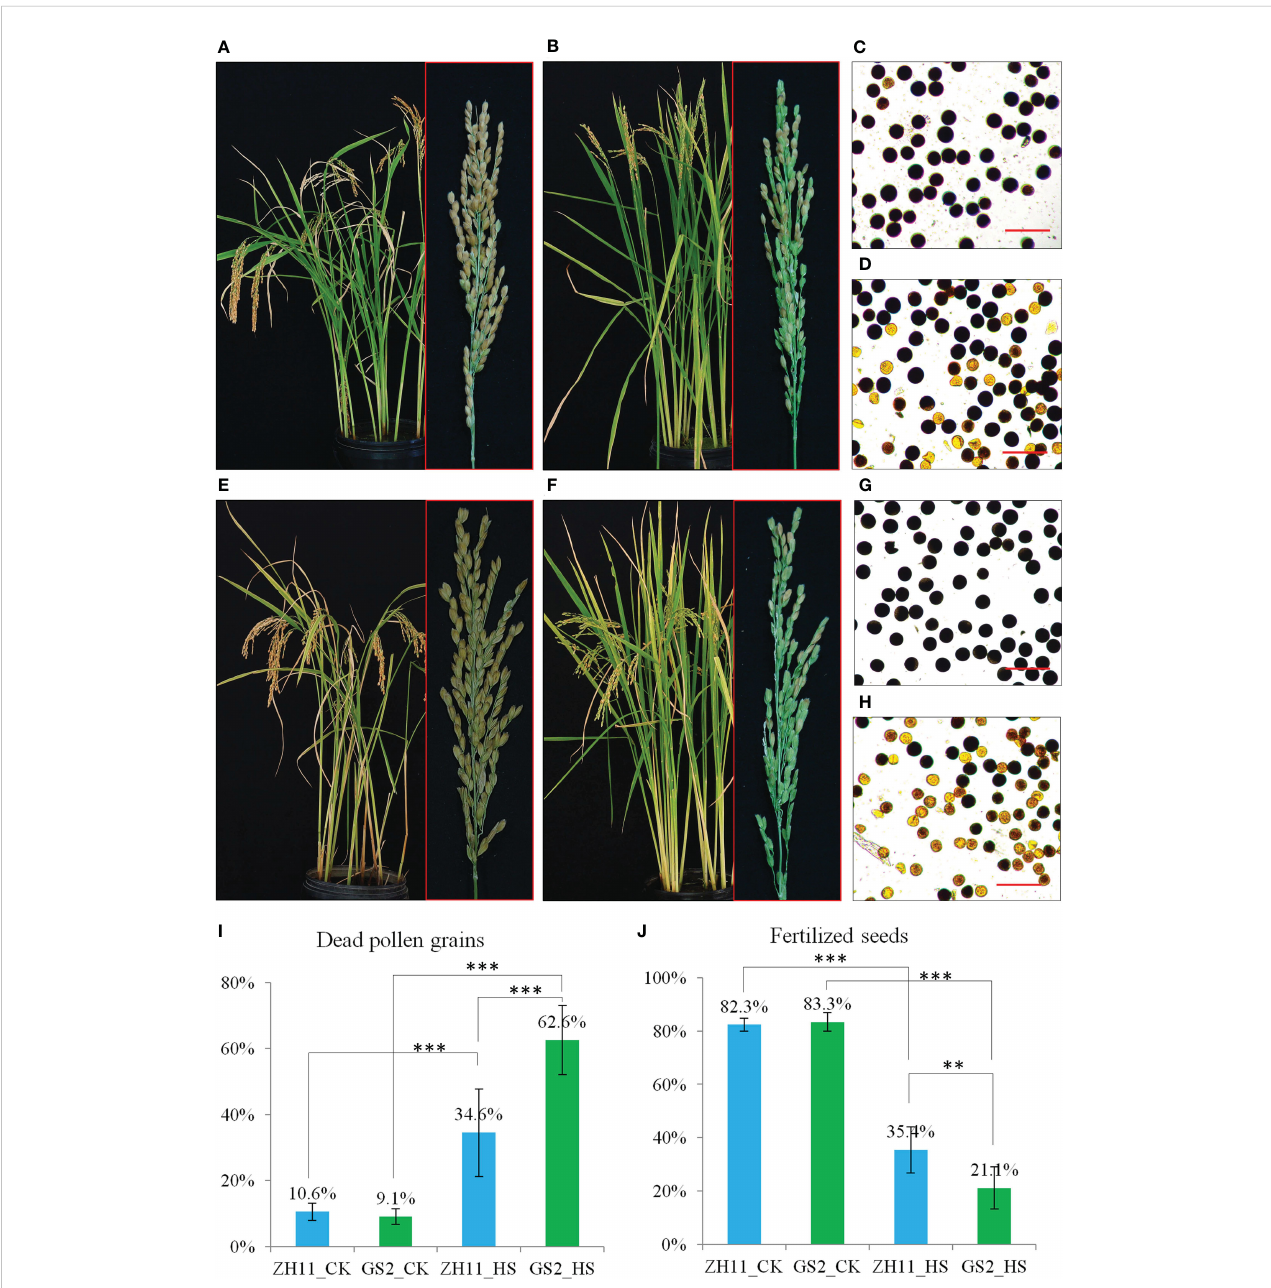
FIGURE 1 Phenotypes of Zhonghua 11 (ZH11) and grain size on chromosome 2 (GS2) under different temperature conditions at the pollen mother cell meiosis stage. (A – D) Photographs of whole plants, seed setting, and pollen grains in ZH11 with and without HS treatment. (A, C) Without heat stress (HS) treatment. (B, D) After HS treatment. (E – H) Photographs of whole plants, seed setting, and pollen grains in GS2 with and without HS treatment. (E, G) Without HS treatment. (F, H) After HS treatment. Scale bars in (C, D, G, H) represent 100 µm. (I) Ratios of dead pollen grains. (J) Ratios of fertilized seeds. Signi fi cance level for t -test: ** p < 0.01; *** p <